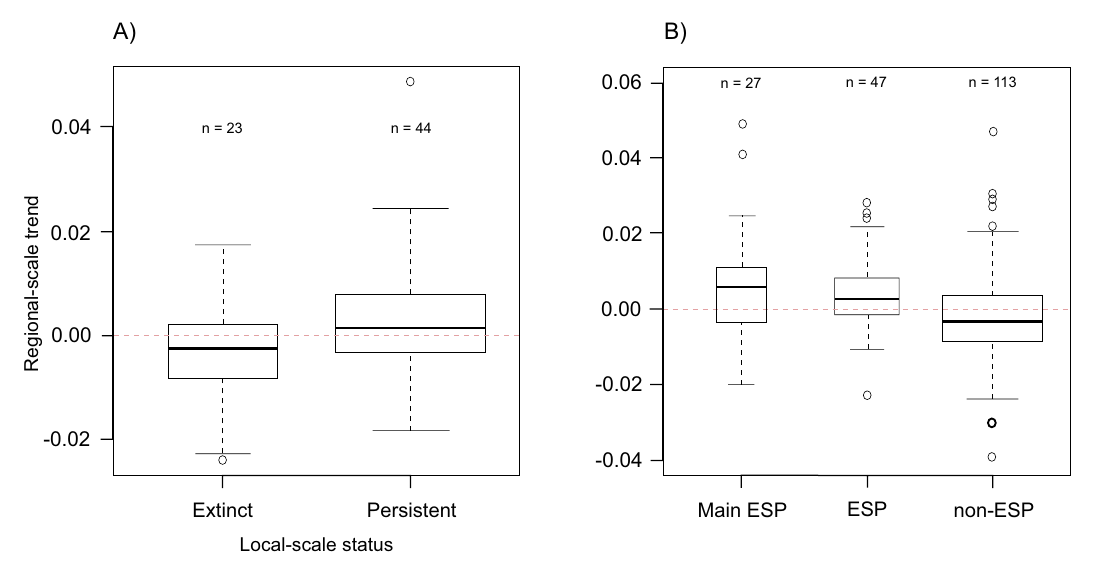
Figure 1. Trend in bee species’ relative abundance in northeastern North American calculated over the period 1870–2011. A ) For species that either became locally extinct or persisted in Carleville, Illinois. B ) For species that either are not ecosystem-service providers to crops (non-ESP), are at least occasionally ecosystem-service providers to crops (ESP), or are among the species cumulatively responsible for 90% of the pollinator visitation to at least one crop (main ESP). Regional data from Bartomeus et al. 5 , local data from Burkle et al. 2 and crop pollinator data from Garibaldi et al. 3